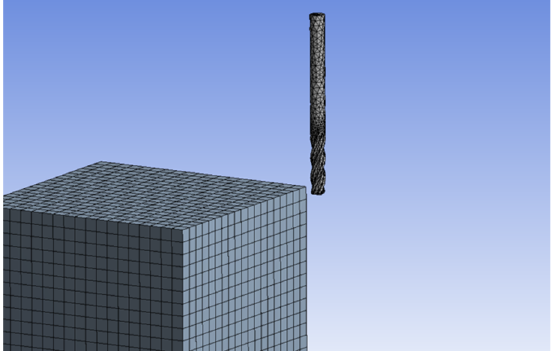
Table 1. Simulation Parameters used in this study.